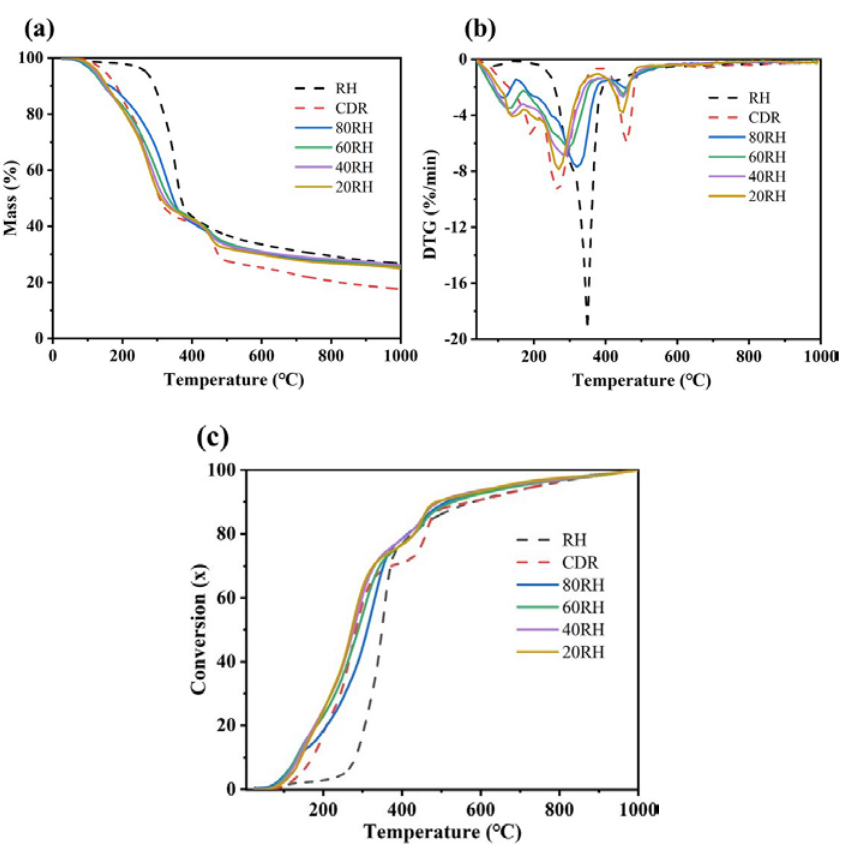
Figure 2. ( a ) TG curves; ( b ) DTG curves; and ( c ) conversion degrees of RH, CDR and blends at 20 °C/min heating rate.